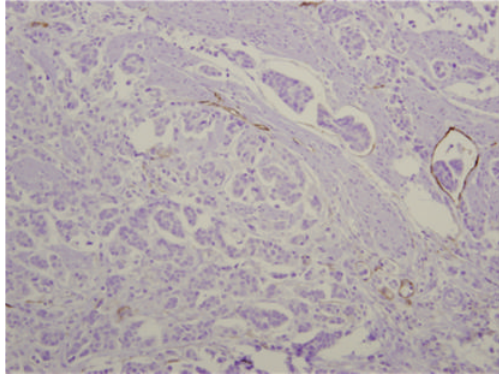
Figure 4: Immunostaining for D2-40 demonstrates a focus of lym- phatic invasion. This stain proves that the bulk of clear lacunar spaces are not true lymphovascular spaces.